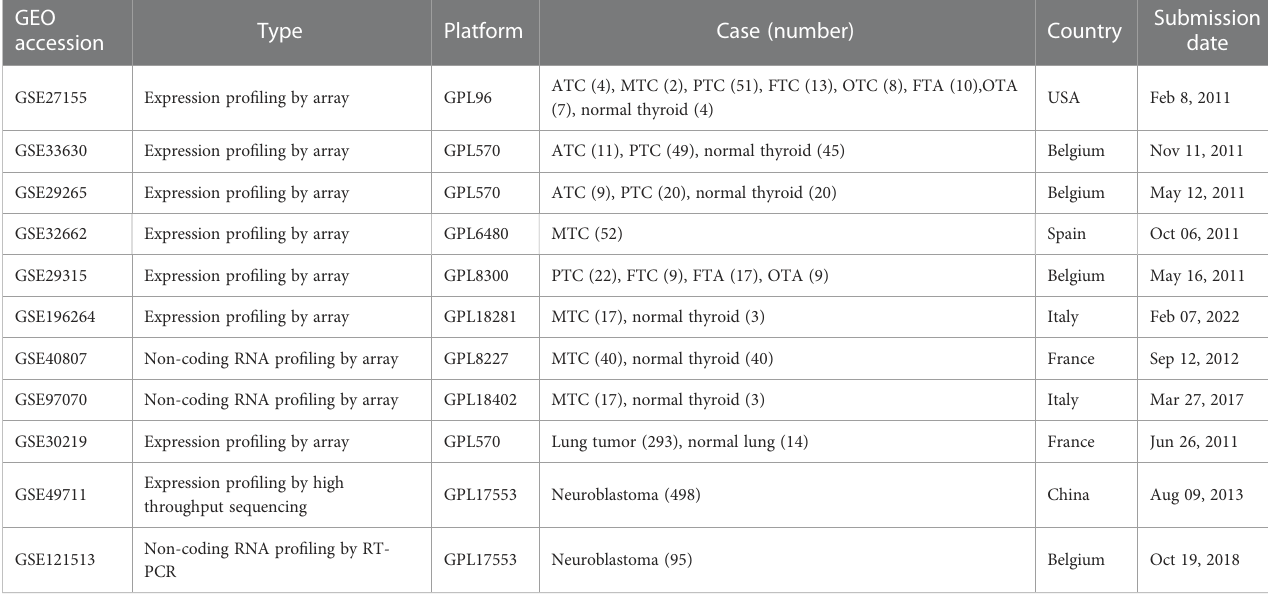
TABLE 1 Characteristics of the expression pro fi le datasets from Gene Expression Omnibus